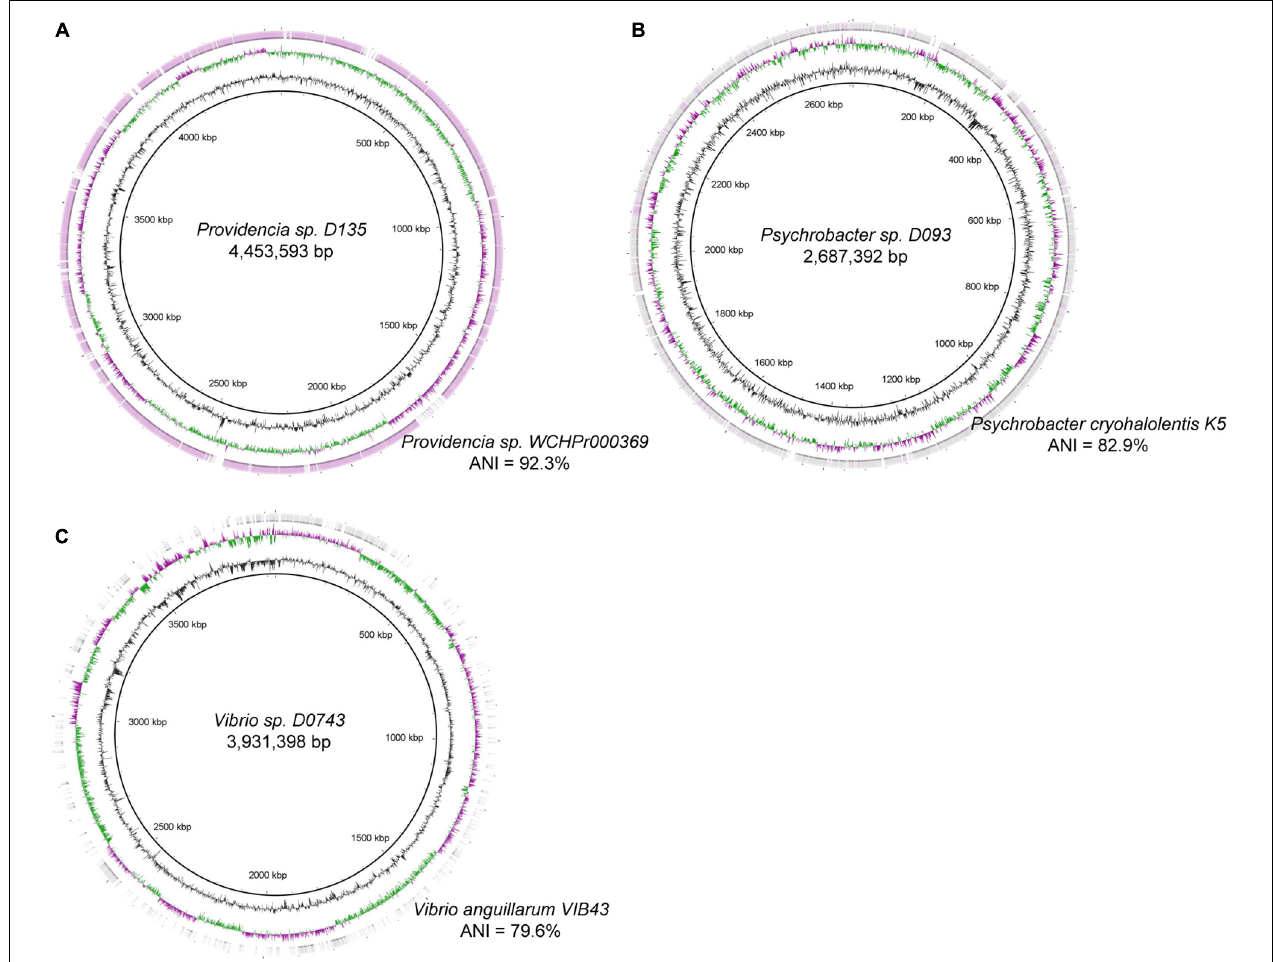
FIGURE 2 | Circular representation of the genomes of four novel species, including (A) Providencia sp. D135 , (B) Psychrobacter sp. D093 , and (C) Vibrio sp. D074 . For each genome, the inner three circles represent the genome scale, G + C skew, and G + C content; the outer circle(s) shows the genome region that have close orthologs with the closest strains in the National Center of Biotechnology Information (NCBI) database. Average nucleotide identity (ANI) of the bile genomes and its closest strains are